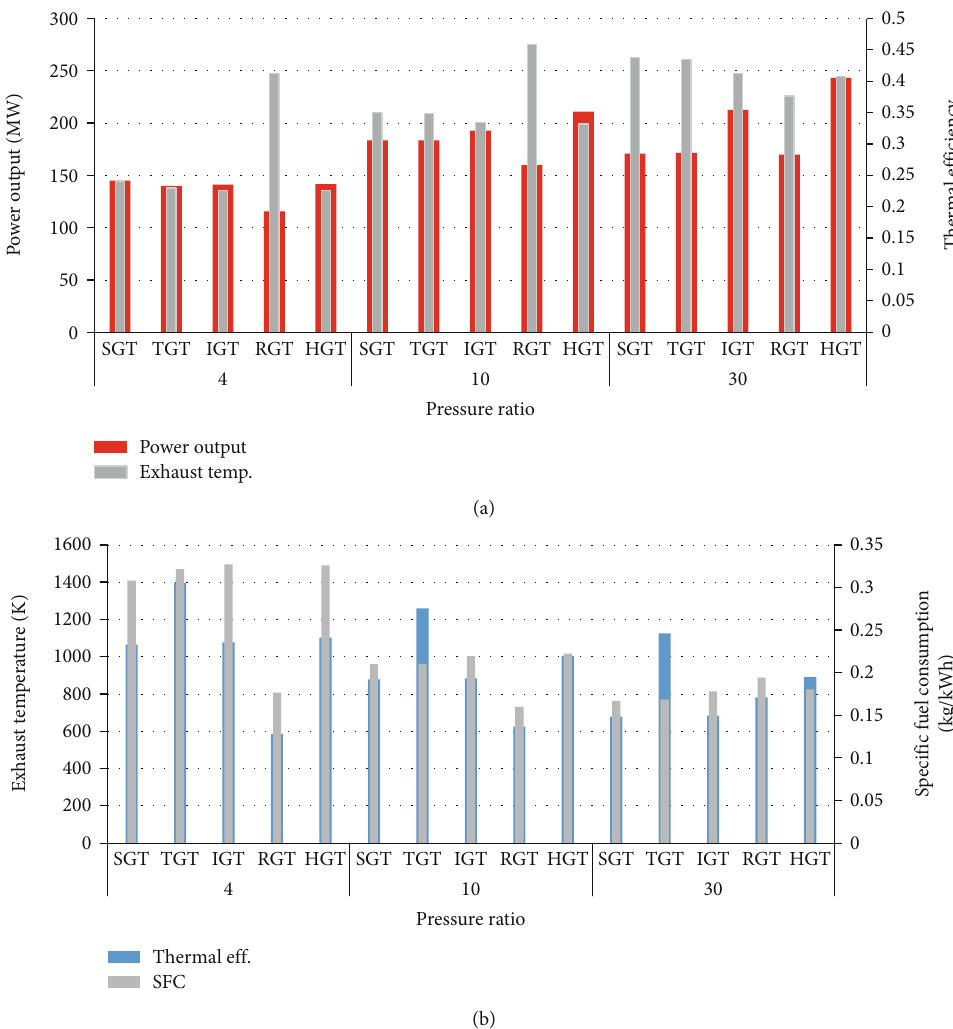
Figure 6: The impact of pressure ratio on the performance of the